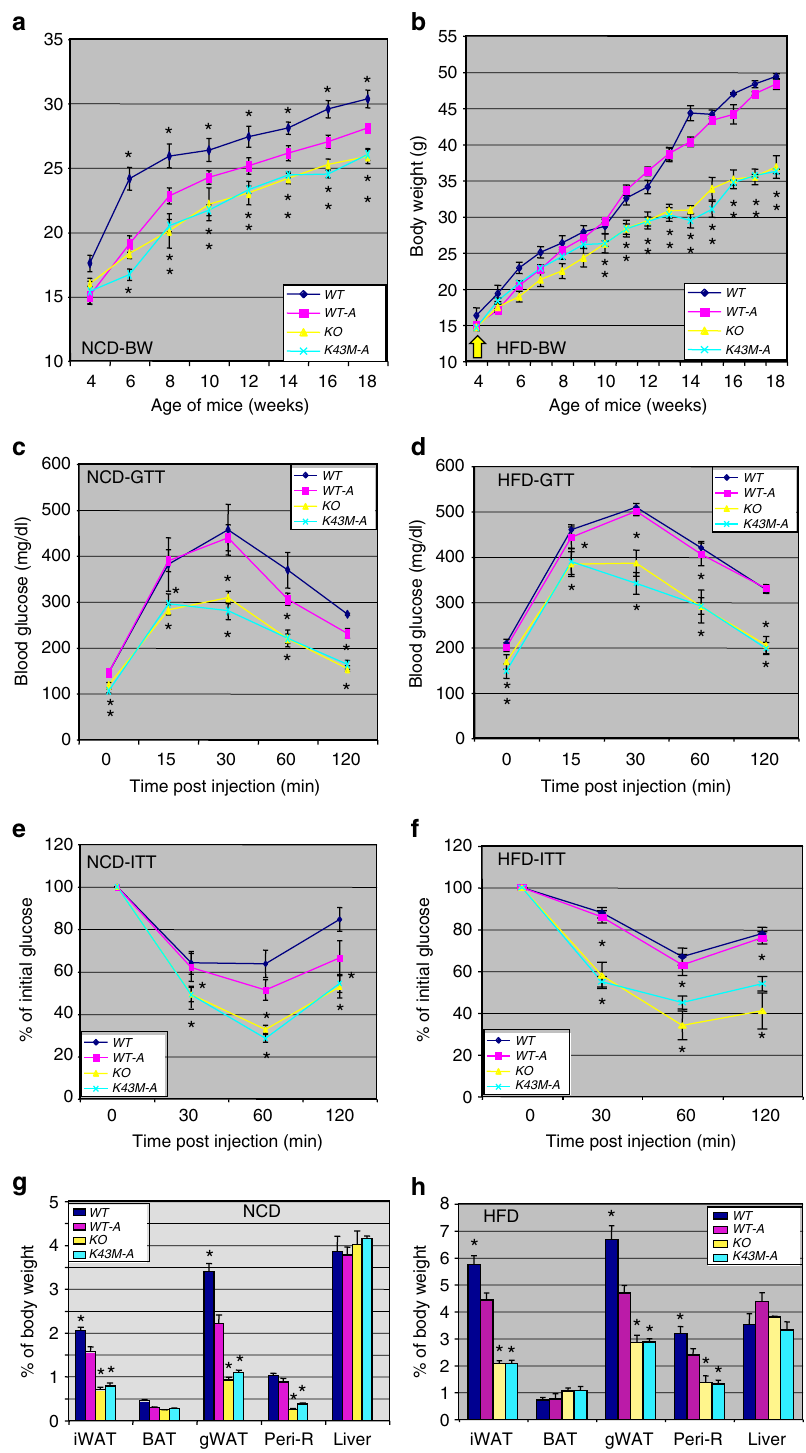
Fig. 5 Re-expression of CDK6 in mature adipocytes reversed the bene fi cial metabolic effects observed in KO mice, whereas re-expression of kinase dead CKD6 recapitulates this metabolic pro fi le. a , b Body weight of age-matched male mice on NCD ( a ) or HFD ( b ) for 14-week observation time. HFD started at age of 4 weeks. c , d GTT after 18 weeks on NCD ( c ) or HFD ( d ). e , f ITT after 18 weeks on NCD ( e ) or HFD ( f ). g , h Mass of various fat pads was normalized to body weight of male mice on NCD ( g ) or HFD ( h ) at age of 18 weeks. No signi fi cant changes were observed in the masses of BAT and livers in those mice under NCD and HFD. For a – h , data are expressed as mean ± S.E. ( n = 10 for each group), * p < 0.05, t -test, vs WT-A . See also Supplementary Fig.